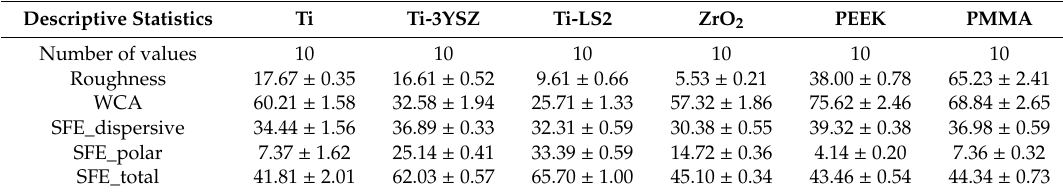
Table 1. Descriptive statistics of all groups’ surface physicochemical experiments (mean ± standard deviation): roughness (nm), water contact angle (WCA) (deg.), dispersive surface free